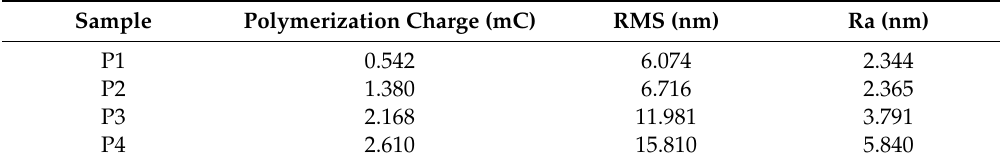
Table 4. Surface characteristics of the films obtained by CPE at 1 V using di ff erent charges from AFM